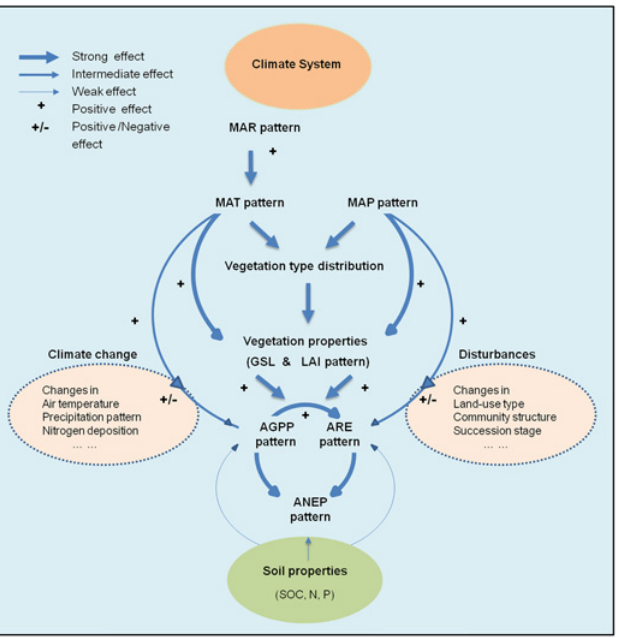
Fig 5. Biogeographic-ecological framework for the spatial variations in AGPP, ARE and ANEP. The width of arrows indicates the strength of effects. Plus sign (+) indicates the positive effects. Plus and minus sign (+/-) indicates the positive or negative effects. MAT: mean annual temperature; MAP: mean annual precipitation; MAR: mean annual solar radiation; GSL: length of growing season; LAI: leaf area index; SOC: soil organic carbon; AGPP: mean annual gross primary production; ARE: mean annual ecosystem respiration; ANEP: mean annual net ecosystem production. (1) Temperature and precipitation patterns together determine the geographical distribution of vegetation types; (2) These various vegetation types represent varying physiognomic properties of vegetation (e.g., leaf area index and length of carbon uptake period) that directly affect the carbon dioxide exchanges and thus shape the spatial patterns of AGPP, ARE and ANEP; (3) Geographic pattern of soil organic carbon content has only a minor and secondary effect on the spatial variations in AGPP, ARE and ANEP; (4) there are considerable variations not captured by the evaluated climate and vegetation factors because of the impacts of climate change and disturbances and so